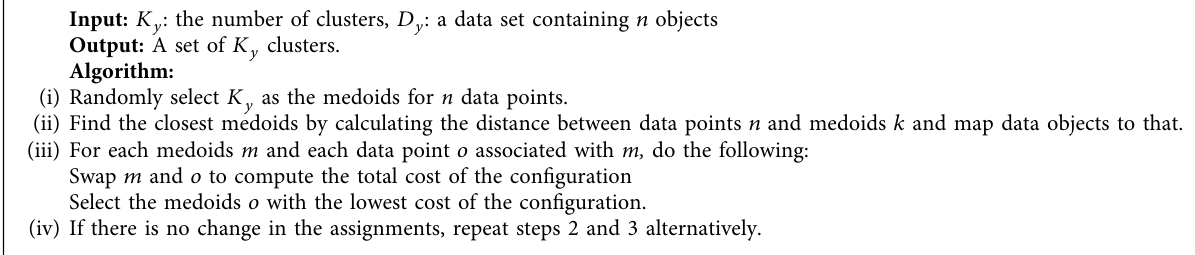
A LGORITHM 2: K-medoids cluster